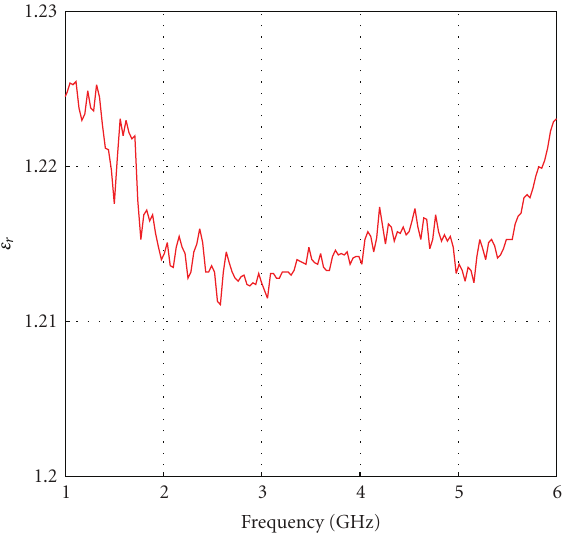
Figure 4: Measured permittivity versus frequency for